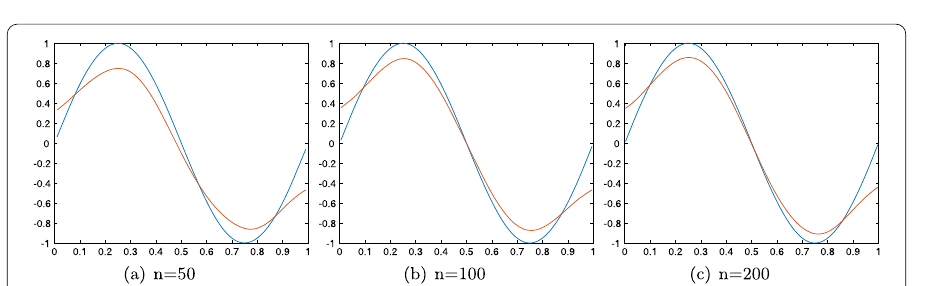
Figure 3 p = 0.25, n = 50, 100 and 200, the fitting figure for ˆ g I 2 n